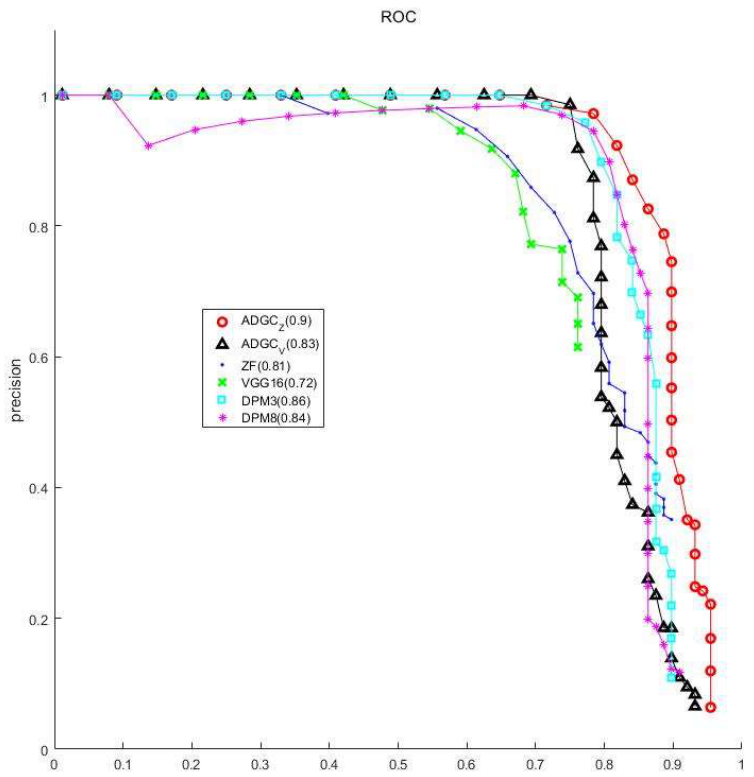
Figure 10. Receiver operating characteristic (ROC) curves for the virtual samples. Table 1. Detection results for real images using the virtual dataset as the training